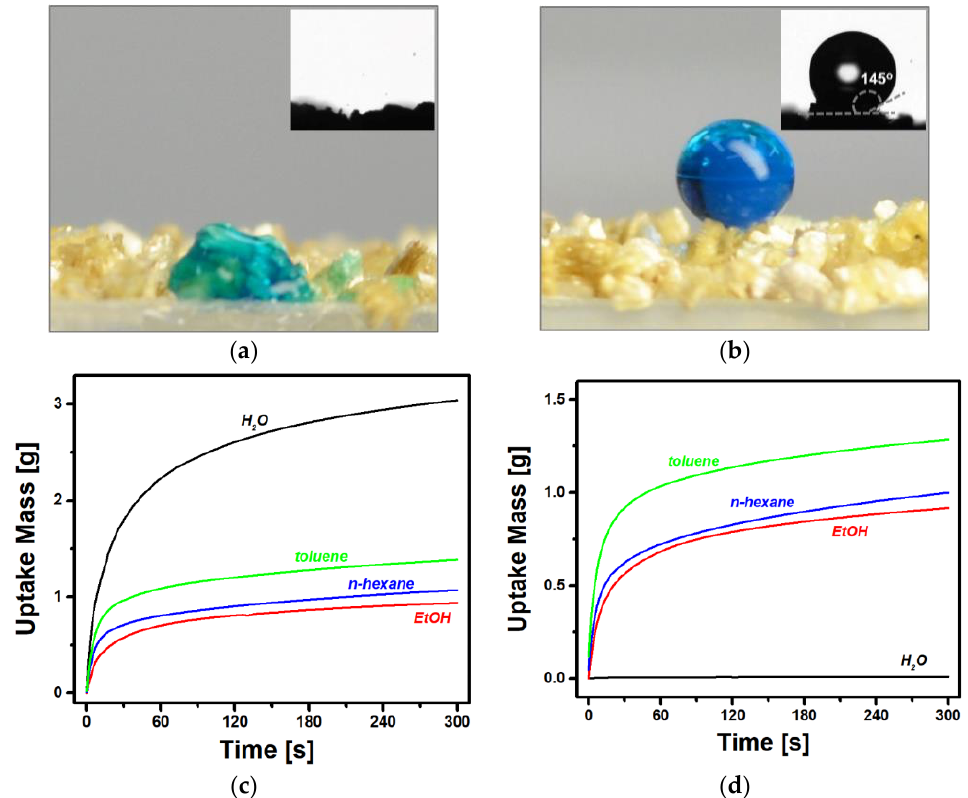
Figure 4. Optical images of ( a ) eVMT and ( b ) eVMT@PDMS after dispensing a 2 µL water droplet on the surface. The insets display water contact angles and water was stained by a blue dye. Time-dependent uptake mass variations for four different liquids along the capillary tubes packed with ( c ) eVMT and ( d ) eVMT@PDMS particles.